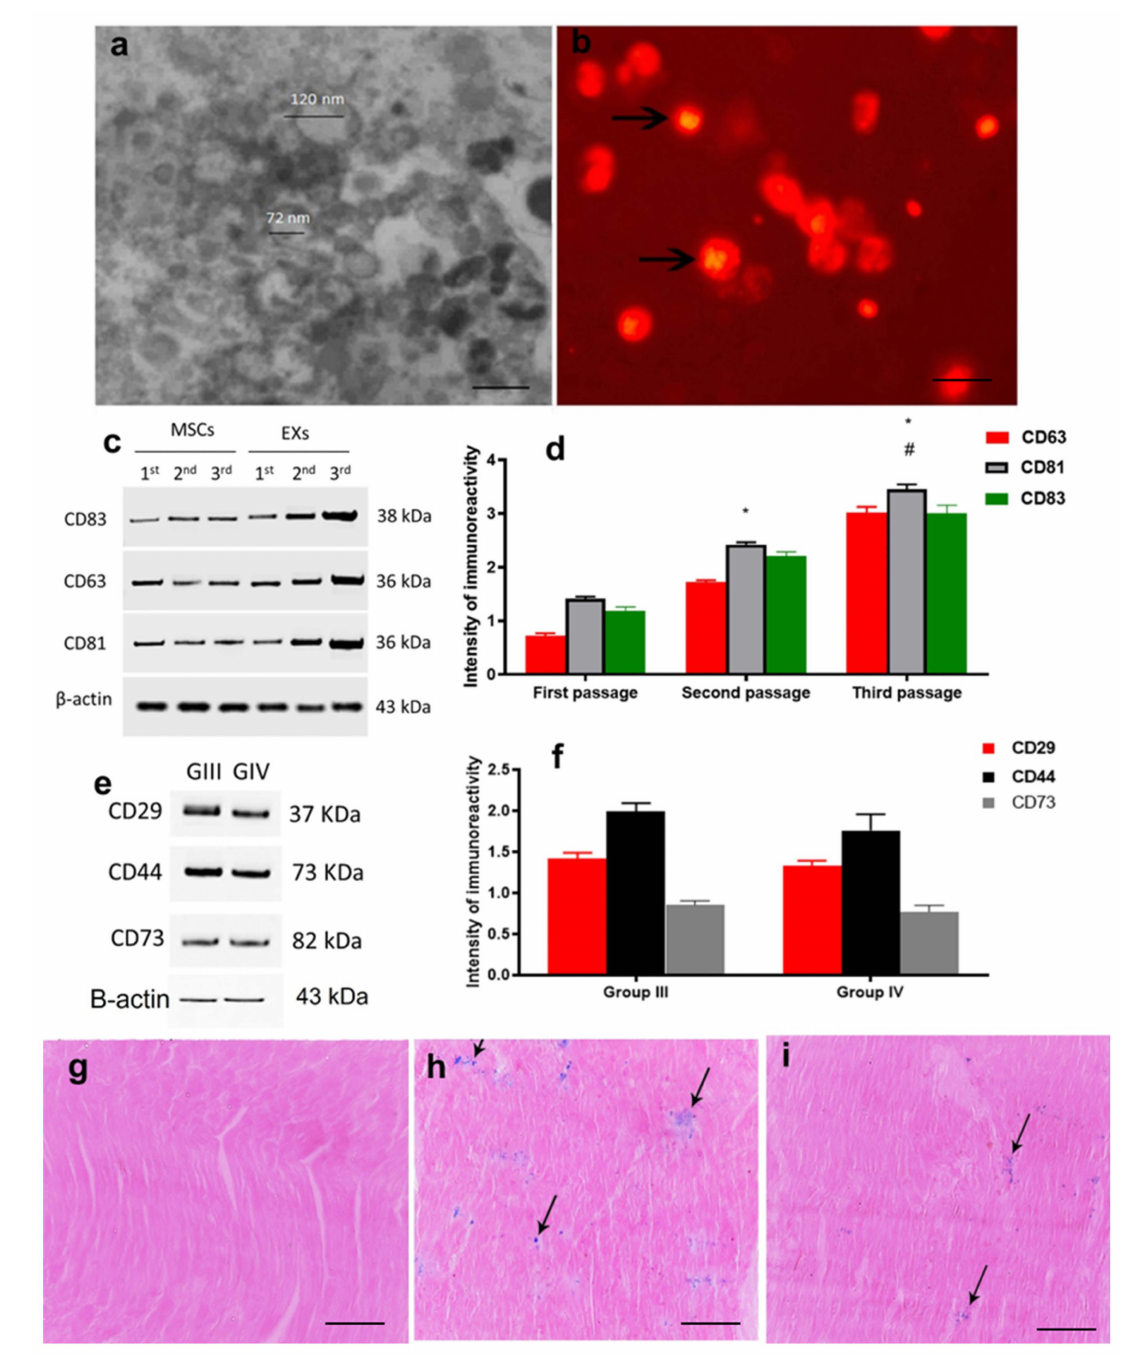
Figure 1. ( a ) TEM of exosomes showing spheroid double-membrane-bound morphology (arrows) with a diameter of 40–100 nm; ( b ) Exosomes were also detected in cardiac tissues by PKH26; ( c ) West- ern blot for exosome characterization; ( d ) Histogram of exosome characterization for CD81, CD63, CD83 indicated significant differences ( p < 0.05) *, significant compared to the first passage at p < 0.05; #, significant compared to the second passage at p < 0.05. Data are shown as mean ± SEM; ( e ) Western blot for exosome localization in cardiac tissues; ( f ) Histogram of exosome localization in groups III and IV for CD29, CD44, and CD73. Data are shown as mean ± SEM. Prussian blue staining of cardiac tissues proved the absence of blue staining in un-injected animals ( g ) and iron oxide particles stained blue in the myocardium of exosome-injected animals in the protective ( h ) and curative ( i )